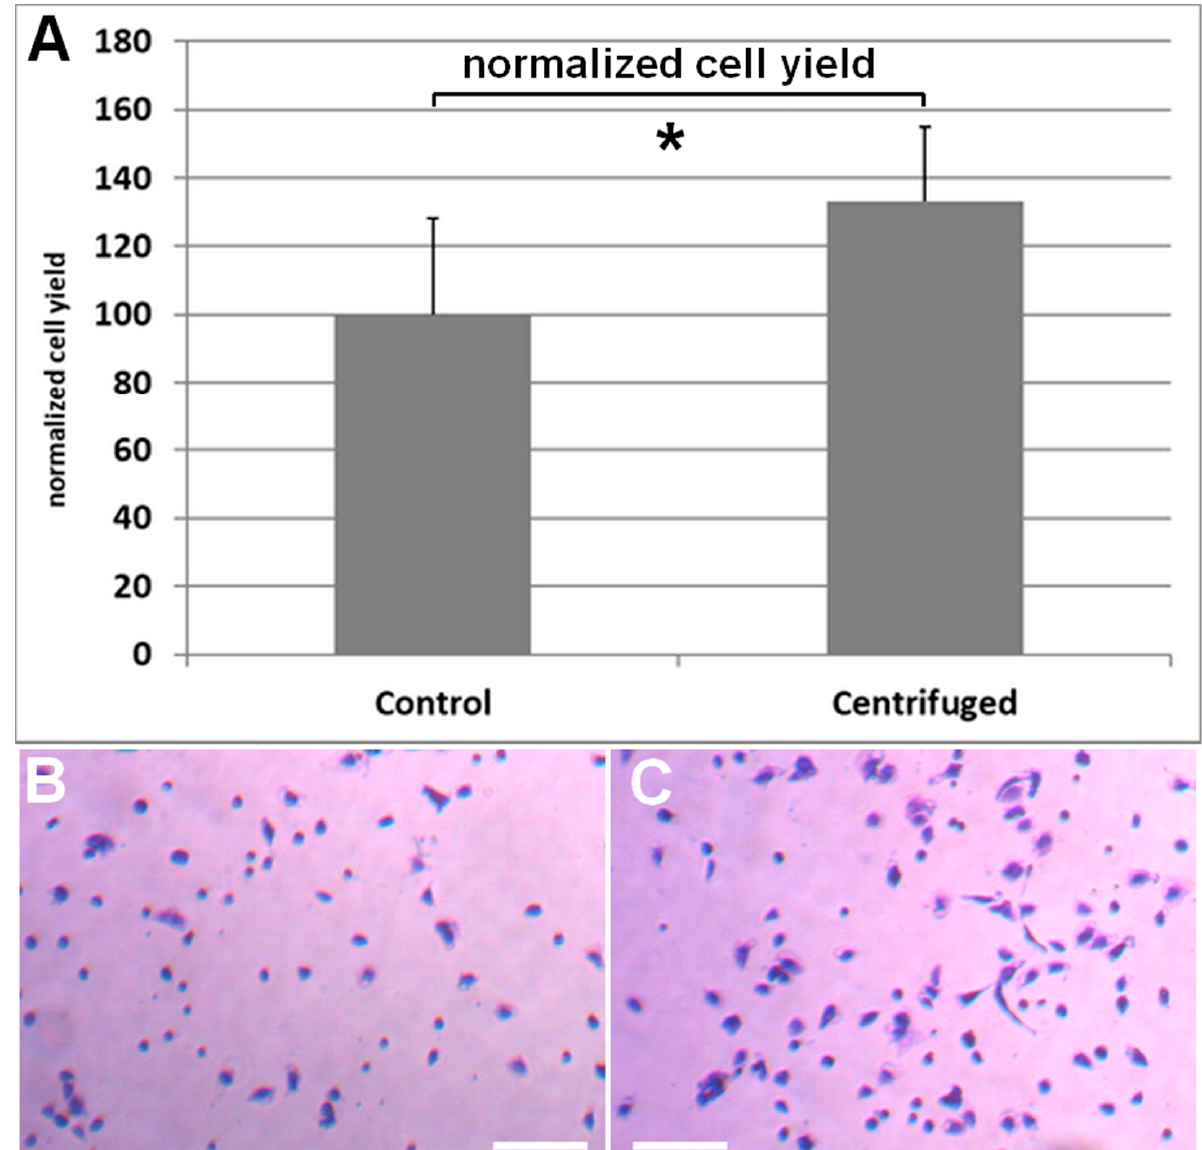
Figure 2. ( A ) Cell yield is increased 1.3-fold per mL when lipoaspirate is centrifuged directly after liposuction. For this comparison, the counting of adherent cells after 24 h was used. Results are shown as mean ± SD. Student’s t-test was used to assess statistical significance (*: p < 0.05). ( B ) Representative image of cells isolated from sedimented lipoaspirate. ( C ) Representative image of cells isolated from centrifuged lipoaspirate. The bar measures 100 µm.